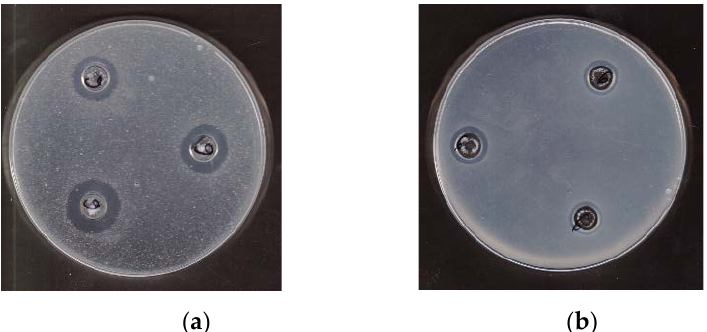
Figure 1. Images of sterile areas found in the investigation of antibacterial activity against model bacteria: аntibacterial effect of peptide fraction MW < 10 kDa on E. coli NBIMCC 8785 at surface cultivation ( a ) and at inoculation in depth ( b ).